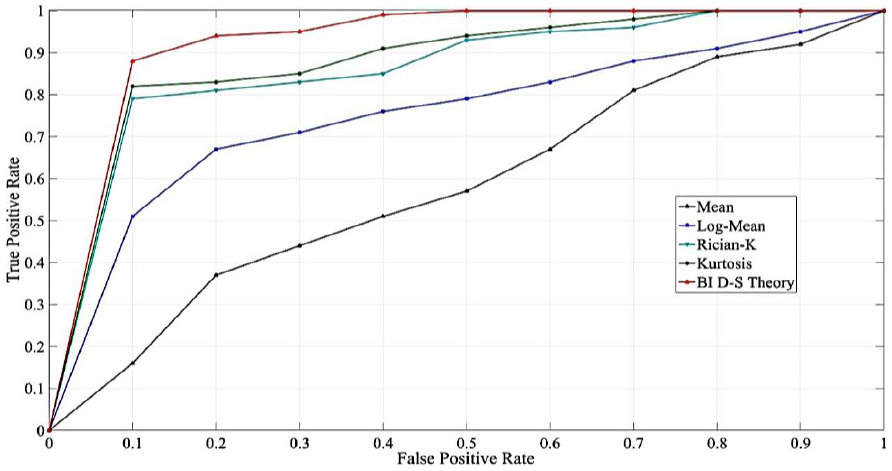
Figure 7. The distinct features comparisons.